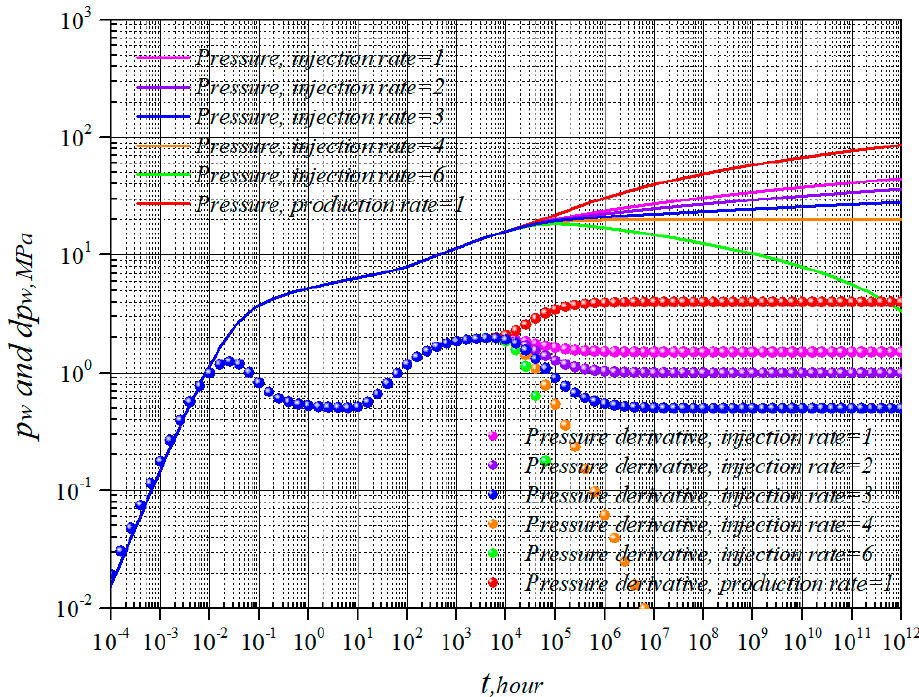
Figure 8. Effect of neighbor well’s injection rate on the tested well’s pressure behaviors in the multi-well system.